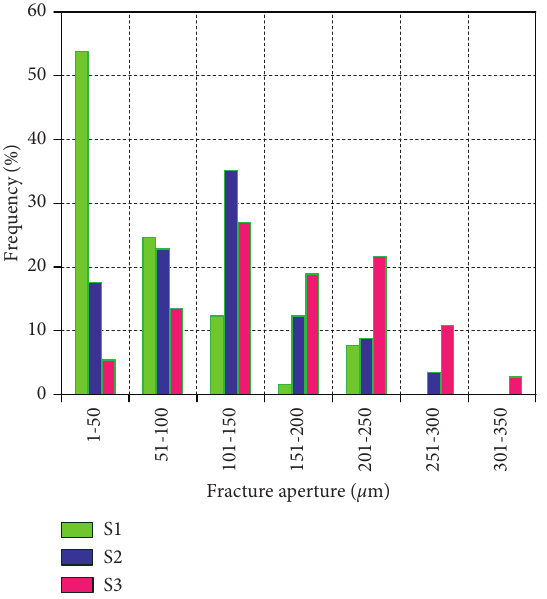
Figure 7: Distribution frequency of HF